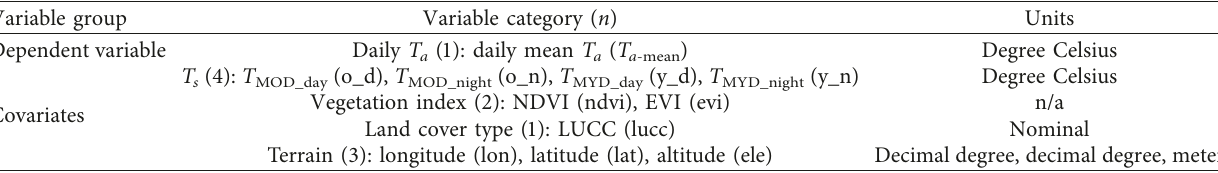
Table 1: Dependent variable and covariates considered in the multivariate linear regression analysis. Variable group